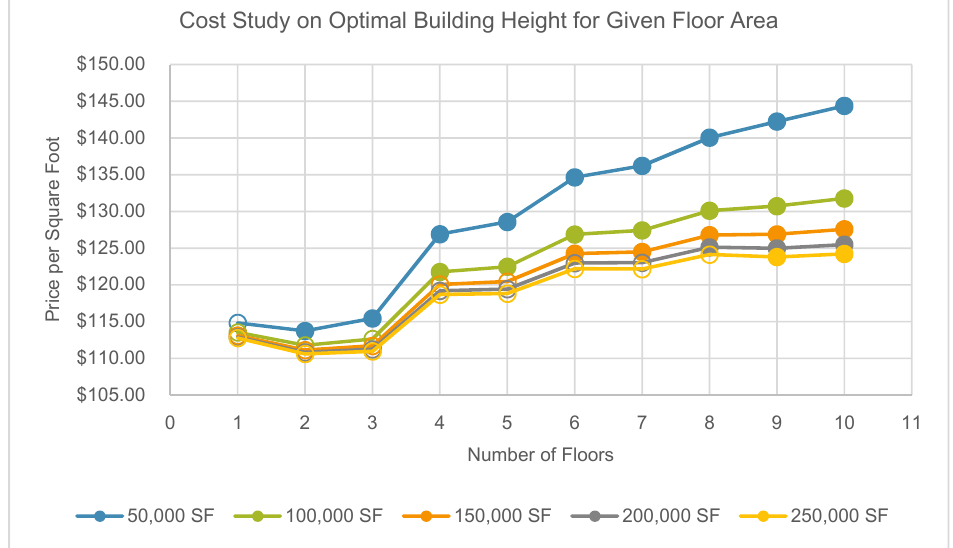
Figure 7. Per Unit Floor Area Costs of Buildings of Various Heights with a Static Total Square Footage. When the footprint of the entire building is held constant, costs make a slightly U- shaped curve for viable solutions. Generally, building a shorter building is more econom- ical. This stands to reason, given that taller buildings require additional structure and ver- tical circulation equipment. Note that it is difficult to find a square footage in which all building heights are dimensionally viable. This problem is mitigated in the “static foot- print” model below. Figure 8. Per Unit Floor Area Thermal Loss Value of Buildings of Various Heights with a Static Total Square Footage. The case with thermal loss value shows a more U-shaped distribution, with greater envelope performance in buildings of moderate height. As total square footage increases, taller and taller buildings become more and more optimal. This suggests that, to minimize envelope heat transfer, taller buildings are optimal for large square footages while mid- size buildings are optimal for smaller square footages. Viability across floors is limited for